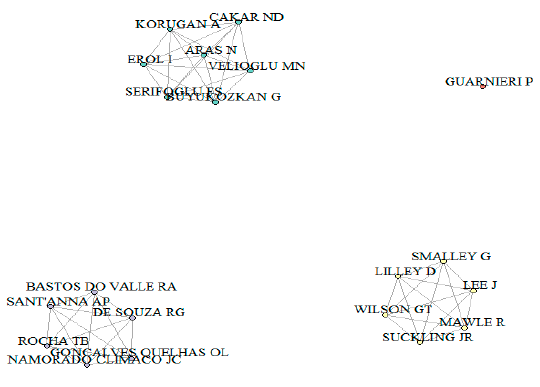
Figure 7. Authors’ coupling.